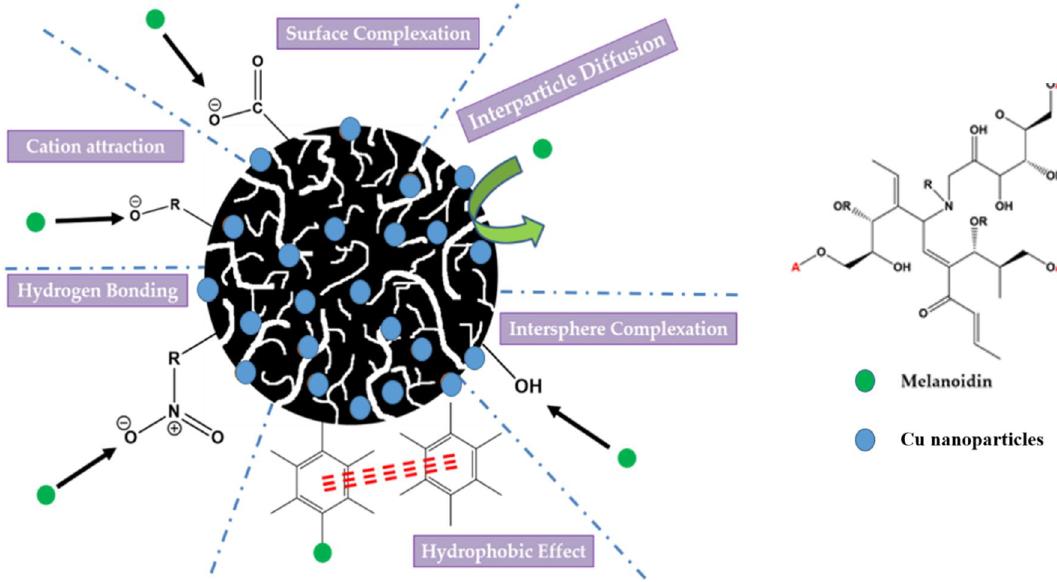
Fig. 5 Plausible mechanism of melanoidin removal via adsorption onto copper-impregnated activated